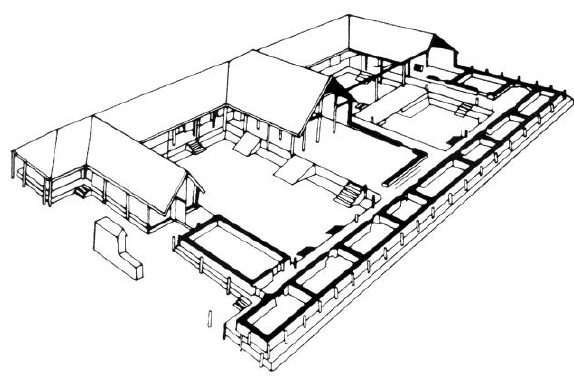
Figure 1. Reconstruction drawing of a large courtyard house compound at Fengchu, Qishan, Shaanxi province, Western Zhou period (1046-771 BCE). Source: Liu, 2002, p.